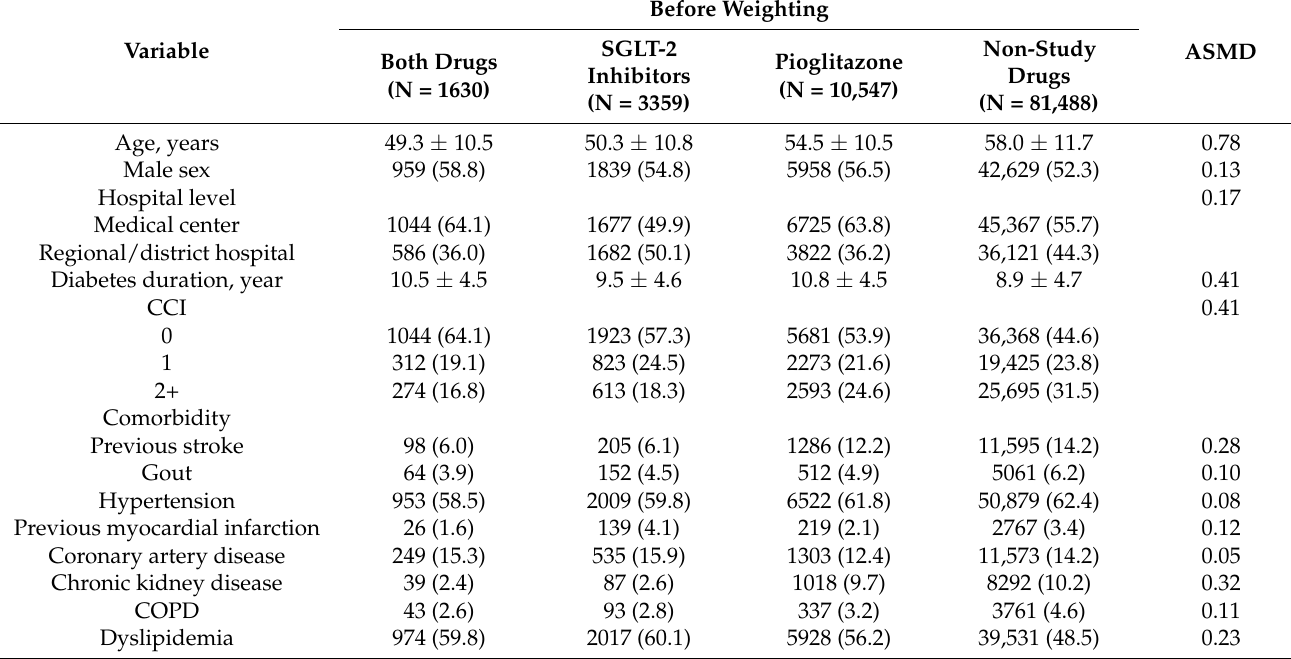
Table 1. Demographic characteristics of the study population before propensity score weighting. Before